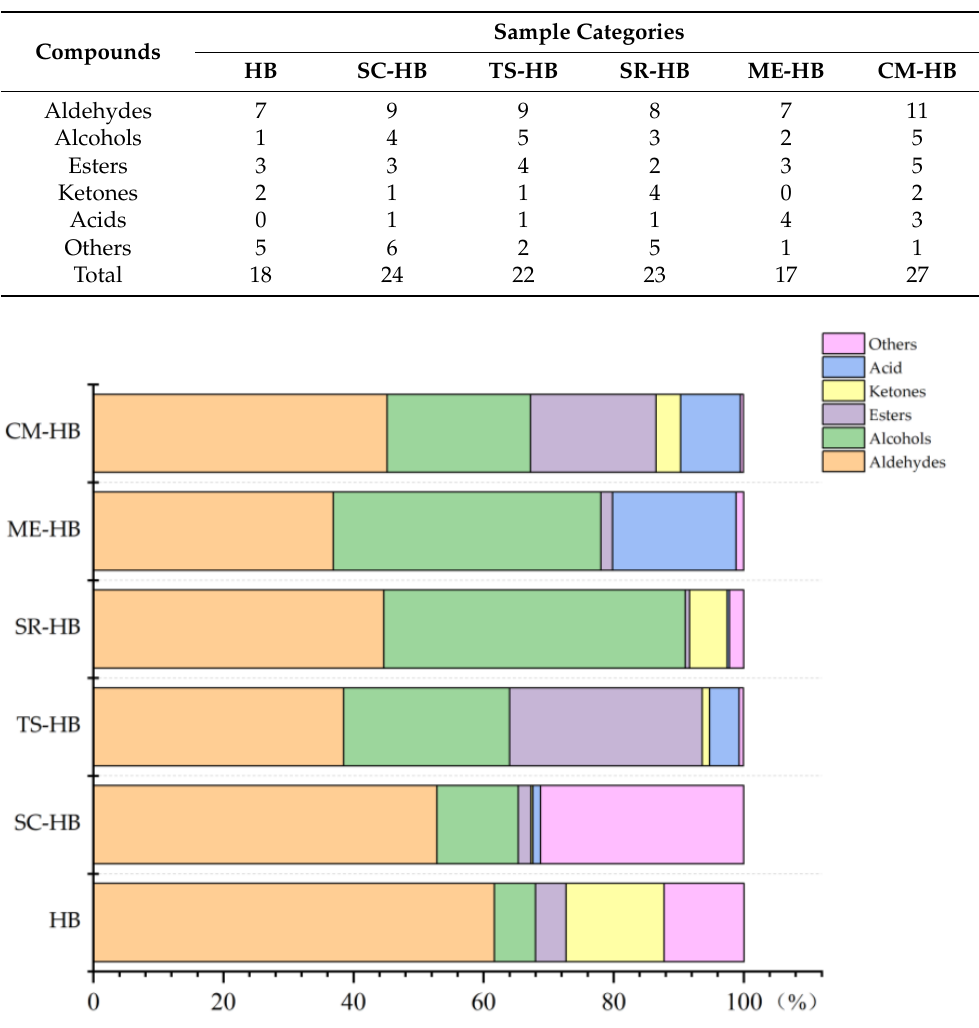
Table 2. Comparison of the classification of volatile components in raw and fermented highland barley samples.